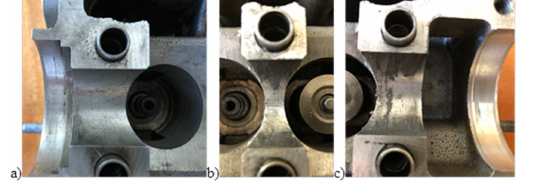
Fig. 19. Appearance of worn bearing bushings of camshaft slide bearings on the cylinder head side, a) bearing 3, b) bearing 2, c) bearing 1